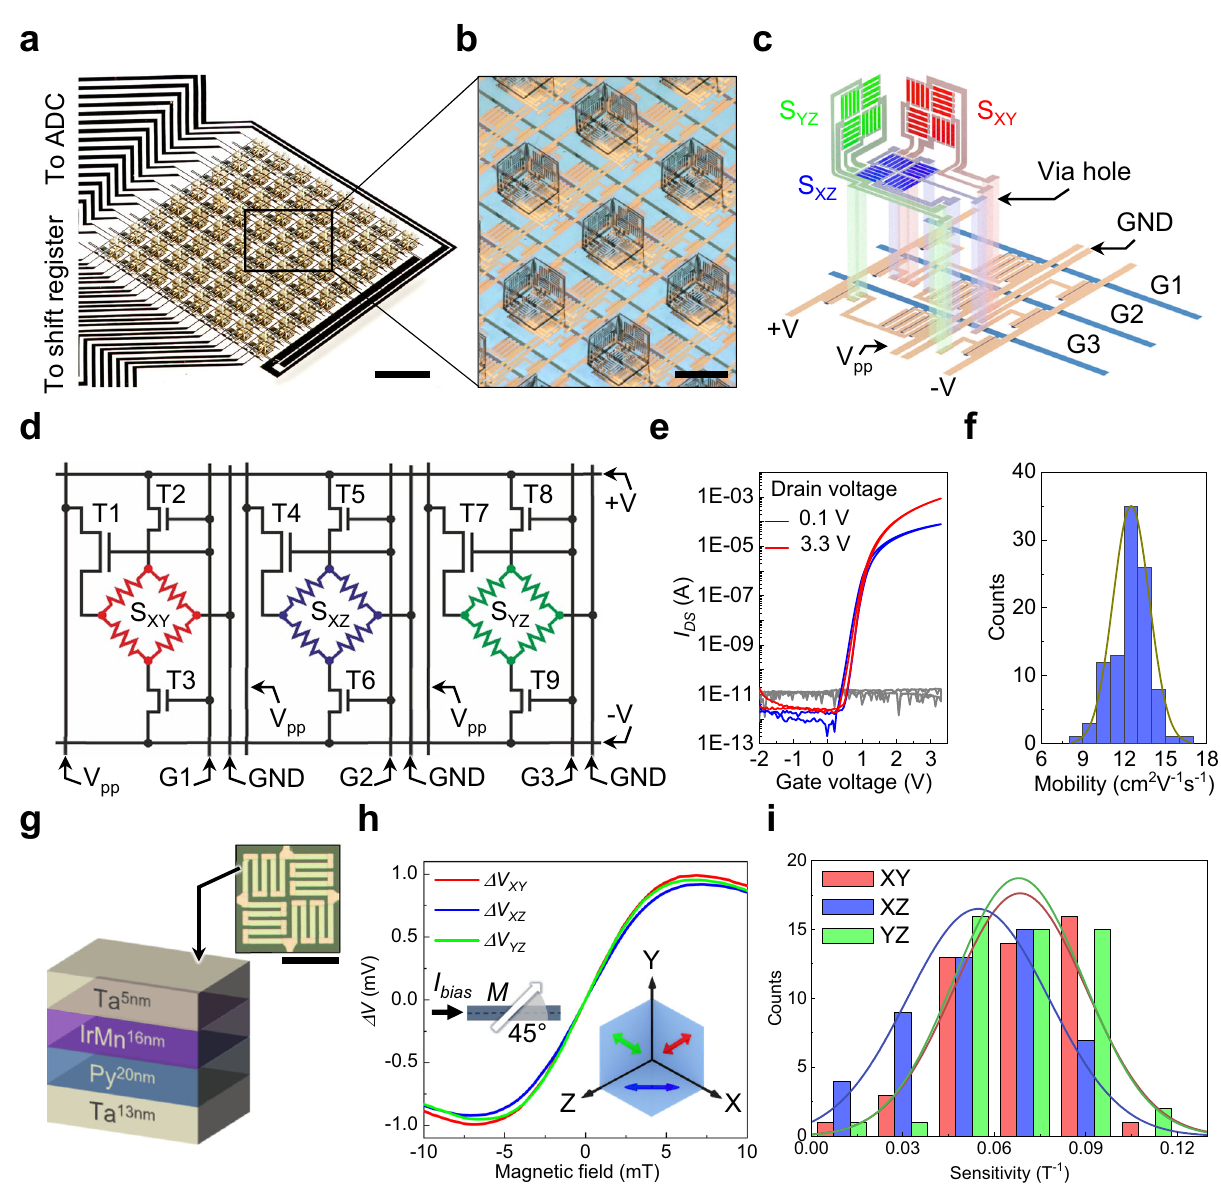
Fig. 2 Structure and magnetoelectrical performance of the IMOS device. a Photo of an IMOS device with 8 × 8 pixel matrix. Scale bar, 2 mm. b Image of the pixel array in the device. The pixel pitch is 1.1 mm × 1.1 mm. Scale bar, 500 µ m. c , d Exploded schematic and circuit diagram of a single pixel which contains three subpixels. The Wheatstone bridge type AMR sensors on the three orthogonal planes are marked as S XY , S XZ and S YZ respectively. e Typical transfer characteristics with V GS from -2 V to 3.3 V for the a-IGZO TFTs. The leakage currents are plotted in gray lines. f Statistics of the mobility µ . Histogram of µ for 100 a-IGZO TFTs. The average µ is (12.51 ± 1.32) cm 2 V − 1 s − 1 . g Schematic illustration of the layer stack of the AMR sensors. Inset is a micrograph of the AMR sensor. Scale bar indicates 200 µ m. h Typical responses of the S XY , S XZ and S YZ sensors. The left inset shows the 45° angle between the bias current and the magnetization direction. The right inset shows the orientations of the sensitivity directions of S XY , S XZ , and S YZ . For all the tests V pp = V G = 3.3 V. i Histograms of the sensitivities for the working sensors on the XY, XZ, YZ planes in a typical 8 × 8 sensor array. The sensitivities are normalized to V pp of 3.3 V. Source data are provided as a Source Data fi